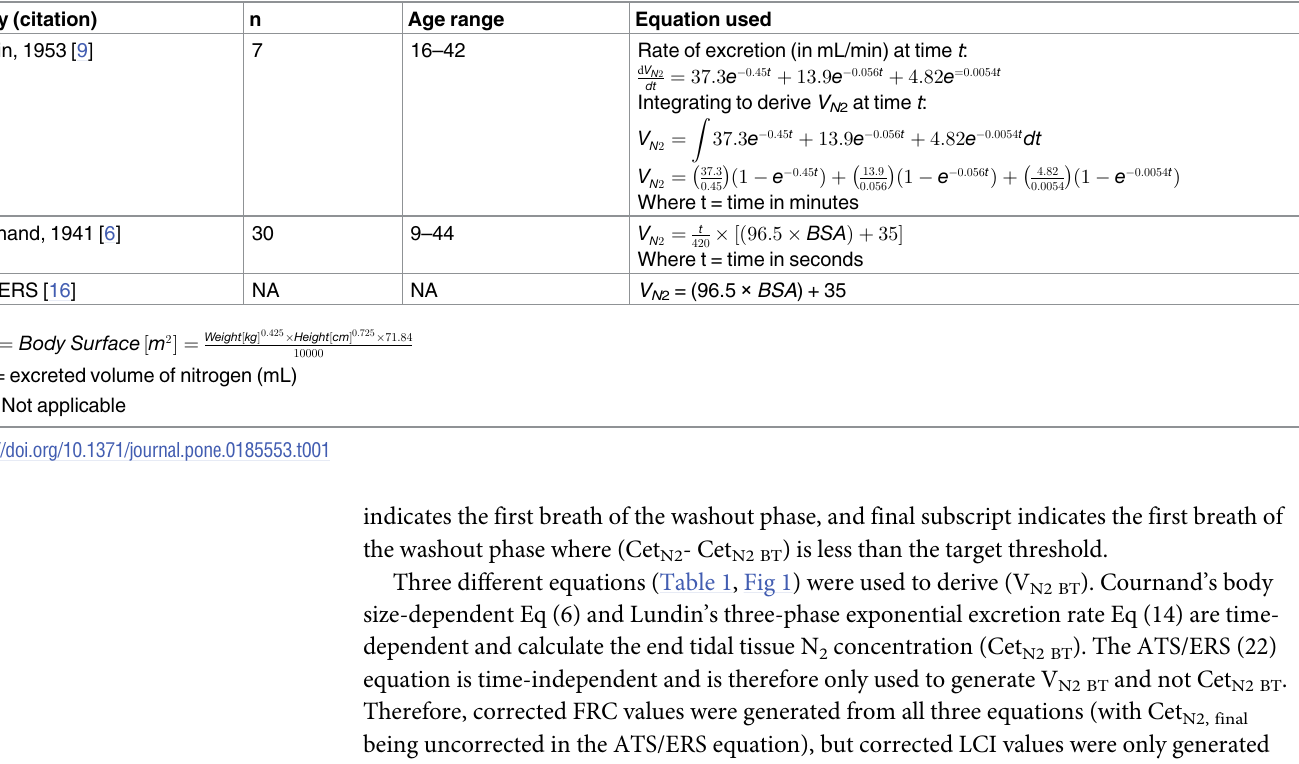
offs and existing software algorithms [18].